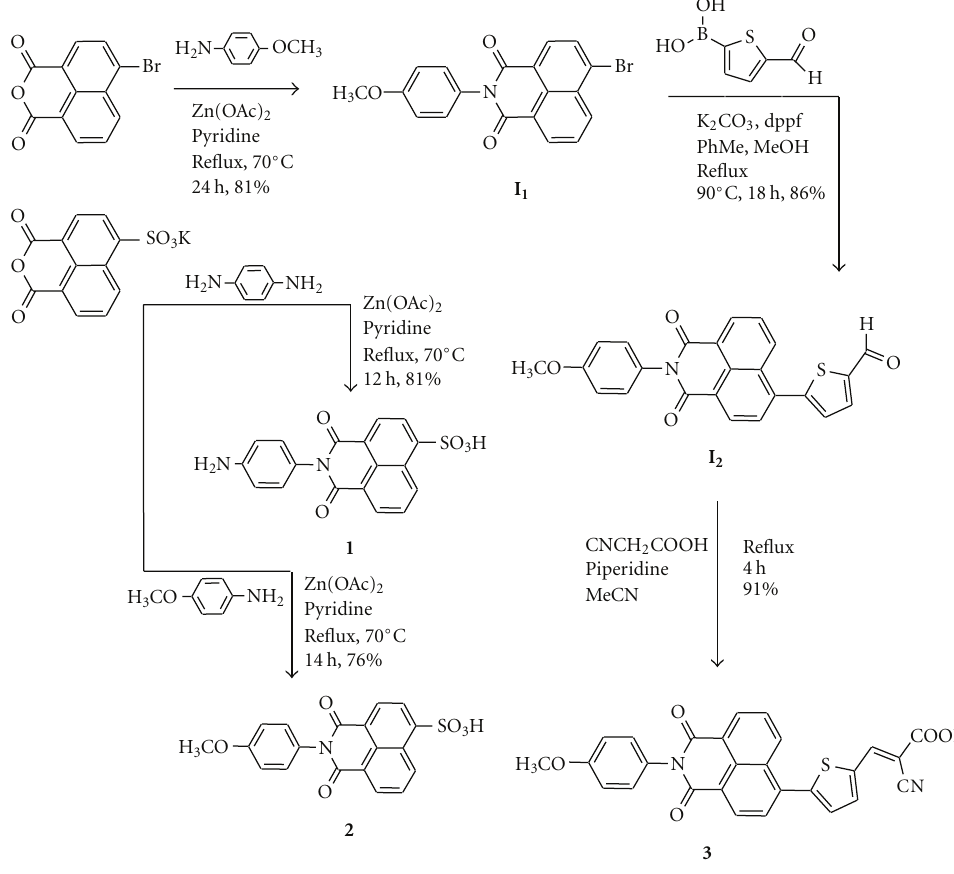
Scheme 1: Synthesis of three